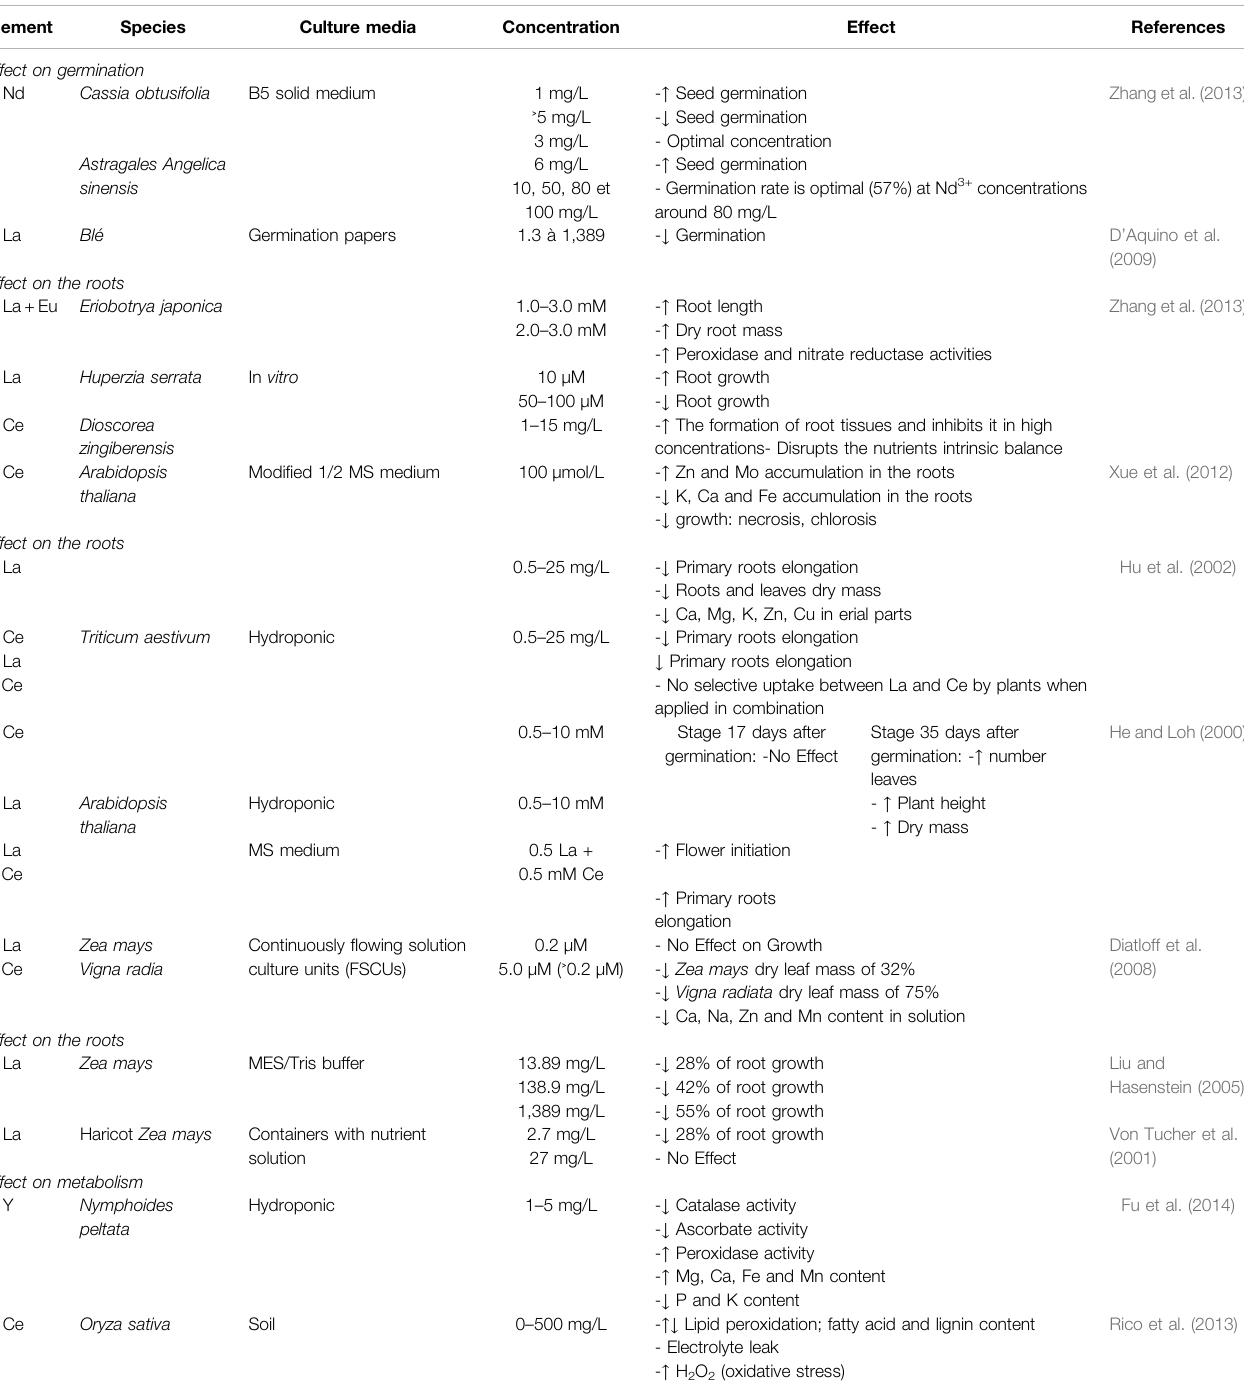
TABLE 4 | Physiological effects of rare earths on seed germination and plant root elongation.